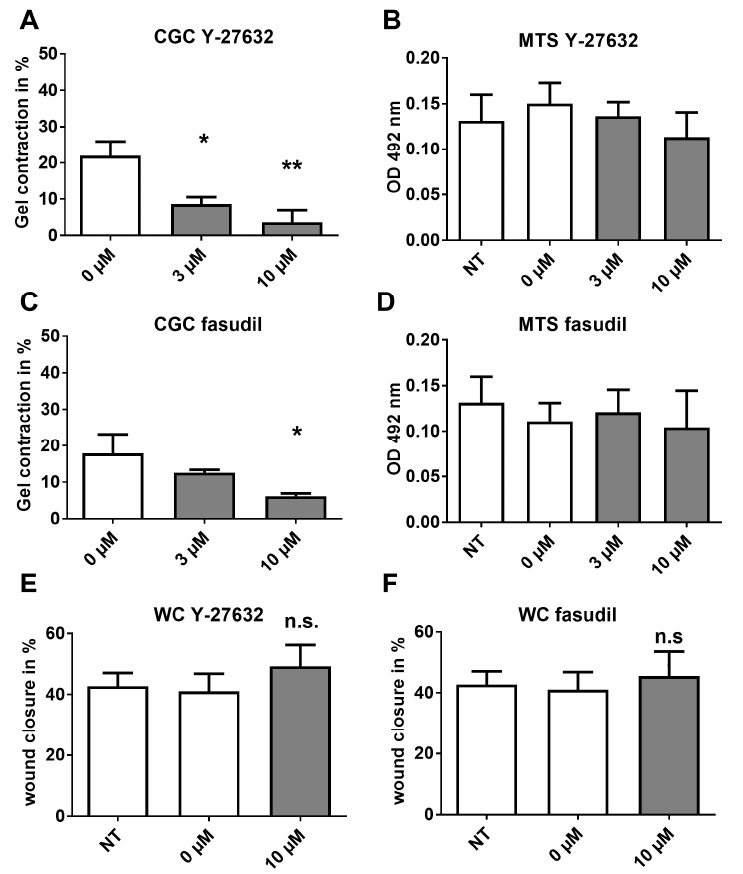
Figure 5. Contractility but not motility regulated via the ROCK pathway. Effects of ROCK inhibitors upon CAF collagen contractility was measured, after which the cell viability was examined by MTS assay. ( A ) The ROCK inhibitor Y-27632 impaired CAF contractility and showed no cytotoxic effects in an MTS assay ( B ); ( C ) The ROCK inhibitor fasudil inhibited CAF contractility with little cytotoxicity ( D ); In the scratch assay, Y-27632 ( E ) and fasudil ( F ) had no effect. ( A – D ) CAF from n = 3 different patients; repeated measures ANOVA; ( E , F ) CAF from n = 4 patients; paired, two-sided t -test. All panels: mean + S.E.M. and asterisks denote the level of significance * for p < 0.05, ** for p < 0.01 and *** for p < 0.001. n.s. = not significant. Incubation times: CGC 48 h, MTS 3 h, WC 24 h.